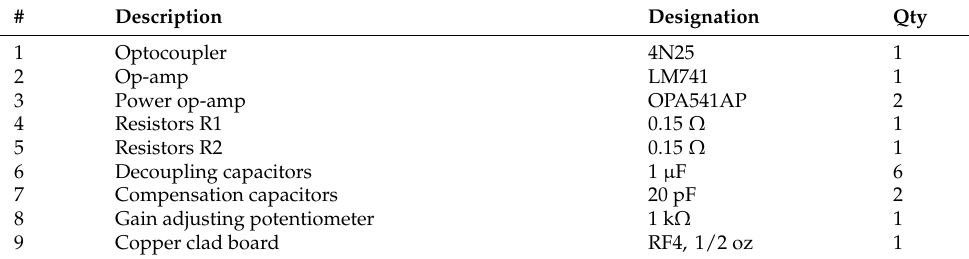
Figure 4. Schematic of the two power driver circuits. This driver is used to supply power to the heating resistors and the thermoelectric modules for cooling. VCC = + 15 V, VEE = − 15 V, and PWM = + 5 V. Table 2. List of electronic components. Designations and quantity of the electronic components used in each thermoelectric module driver circuit used for